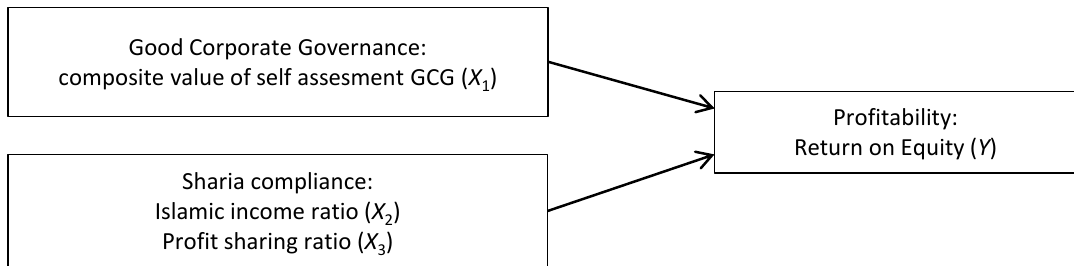
Figure 1. Relation of independent variables with dependent